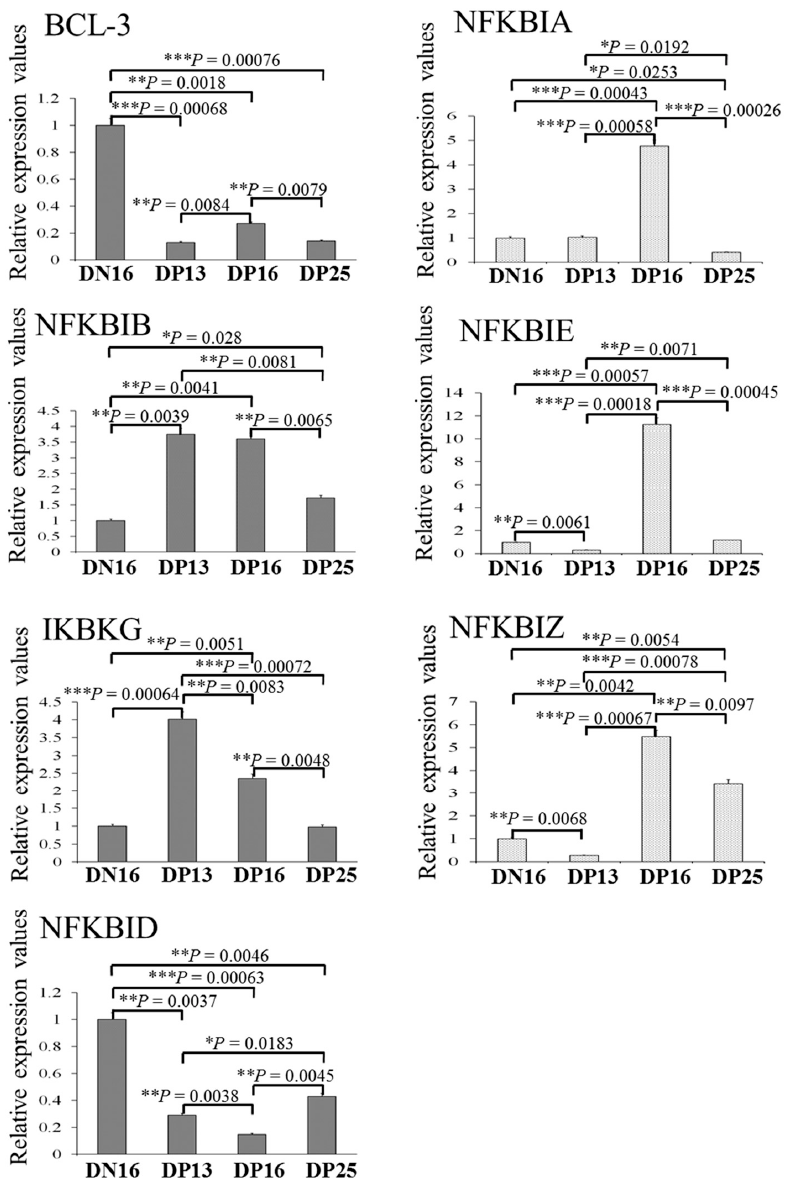
Figure 2. Relative expression values of BCL-3 , NFKBIA , NFKBIB , NFKBIE , IKBKG , NFKBID and NFKBIZ mRNA in the lymph nodes from non-pregnant ewes and pregnant ewes. Note: DN16 = day 16 of the estrous cycle; DP13 = day 13 of pregnancy; DP16 = day 16 of pregnancy; DP25 = day 25 of pregnancy. Significant differences ( p < 0.05) are indicated by different letters within same color columns. p values between 0.01 and 0.05 are shown with one (*) asterisk, and p values between 0.001 and 0.01 are shown with two (**) asterisks, and p value less than 0.001 is designated with three (***) asterisks.